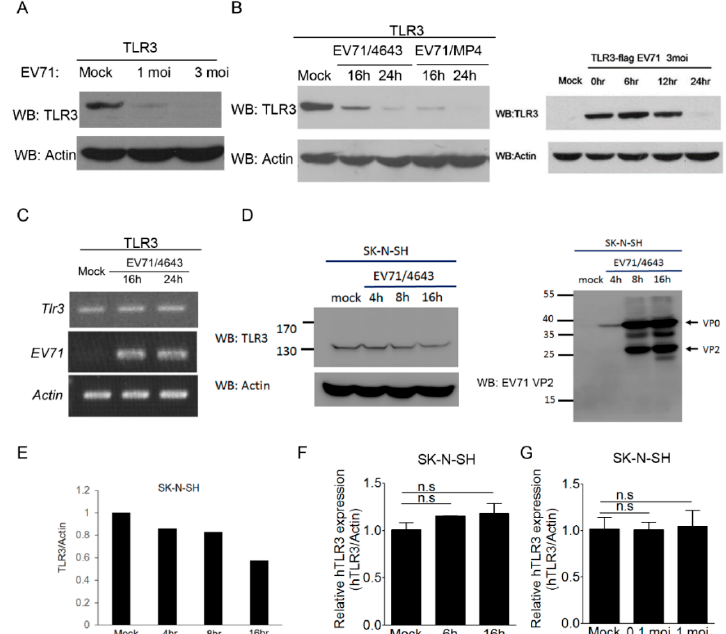
Figure 5. The TLR3 protein level is decreased upon EV-A71 infection. ( A ) HEK293 cells transfected with Flag-tagged TLR3 were left untreated or infected with EV-A71 (MOI, 1 and 3). After 24 h, the treated cells were harvested for the Western blot analysis of TLR3 protein levels. ( B ) Similar to panel A, EV-A71 (4643 strain, MOI, 3) and EV-A71 (MP4 strain, MOI, 1) were used to infect TLR3-transfected HEK293 cells for the indicated times. These cells were then harvested for the Western blot analysis of TLR3. ( C ) Like Panel B, the treated cells were harvested at the indicated times to analyze the mRNA levels of Tlr3 , EV-A71 , and β - Actin by RT-PCR. ( D , E ) SK-N-SH cells were left untreated or infected with EV-A71 (4643 strain, MOI, 0.2) for 4 h, 8h, and 16 h, and the cells were harvested for the Western blot analysis of the endogenous TLR3 protein level. ( F ) SK-N-SH cells were left untreated or infected with EV-A71 (4643 strain, MOI, 0.1), and the cells were harvested at the indicated times (6 h and 16 h) to analyze the mRNA levels of Tlr3 and β - Actin by qRT-PCR. ( G ) SK-N-SH cells were left untreated or infected with EV-A71 (4643 strain, MOI, 0.1 and 1) for 6 h, and the cells were harvested to analyze the mRNA levels of Tlr3 and β - Actin using qRT-PCR. NS stands for “not significant” (Student’s t -test). Data are representative of at least two or three independent